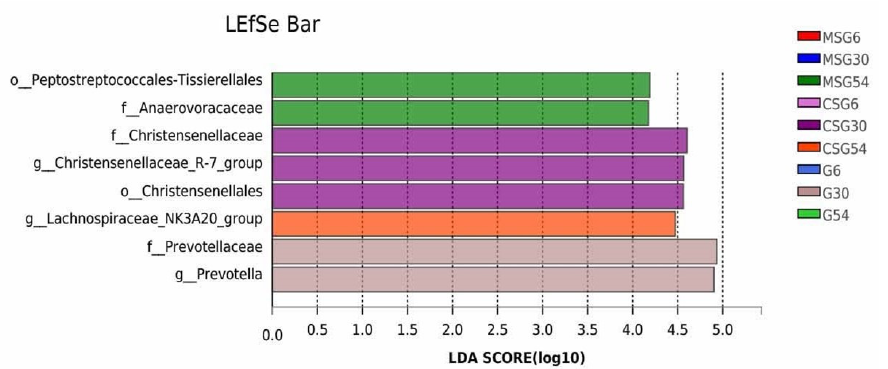
Figure 6. LEfSe results in different ages and supplements. Prefixes represent abbreviations for the taxonomic rank of each taxon; (f-) represents the identification of bacterial taxa significantly different from each group at the family level by LEfSe, (g-) represents the identification of bacterial taxa significantly different from each group at the genus level by LEfSe, and (o-) represents the identification of bacterial taxa significantly different from each group at the order level by LEfSe.